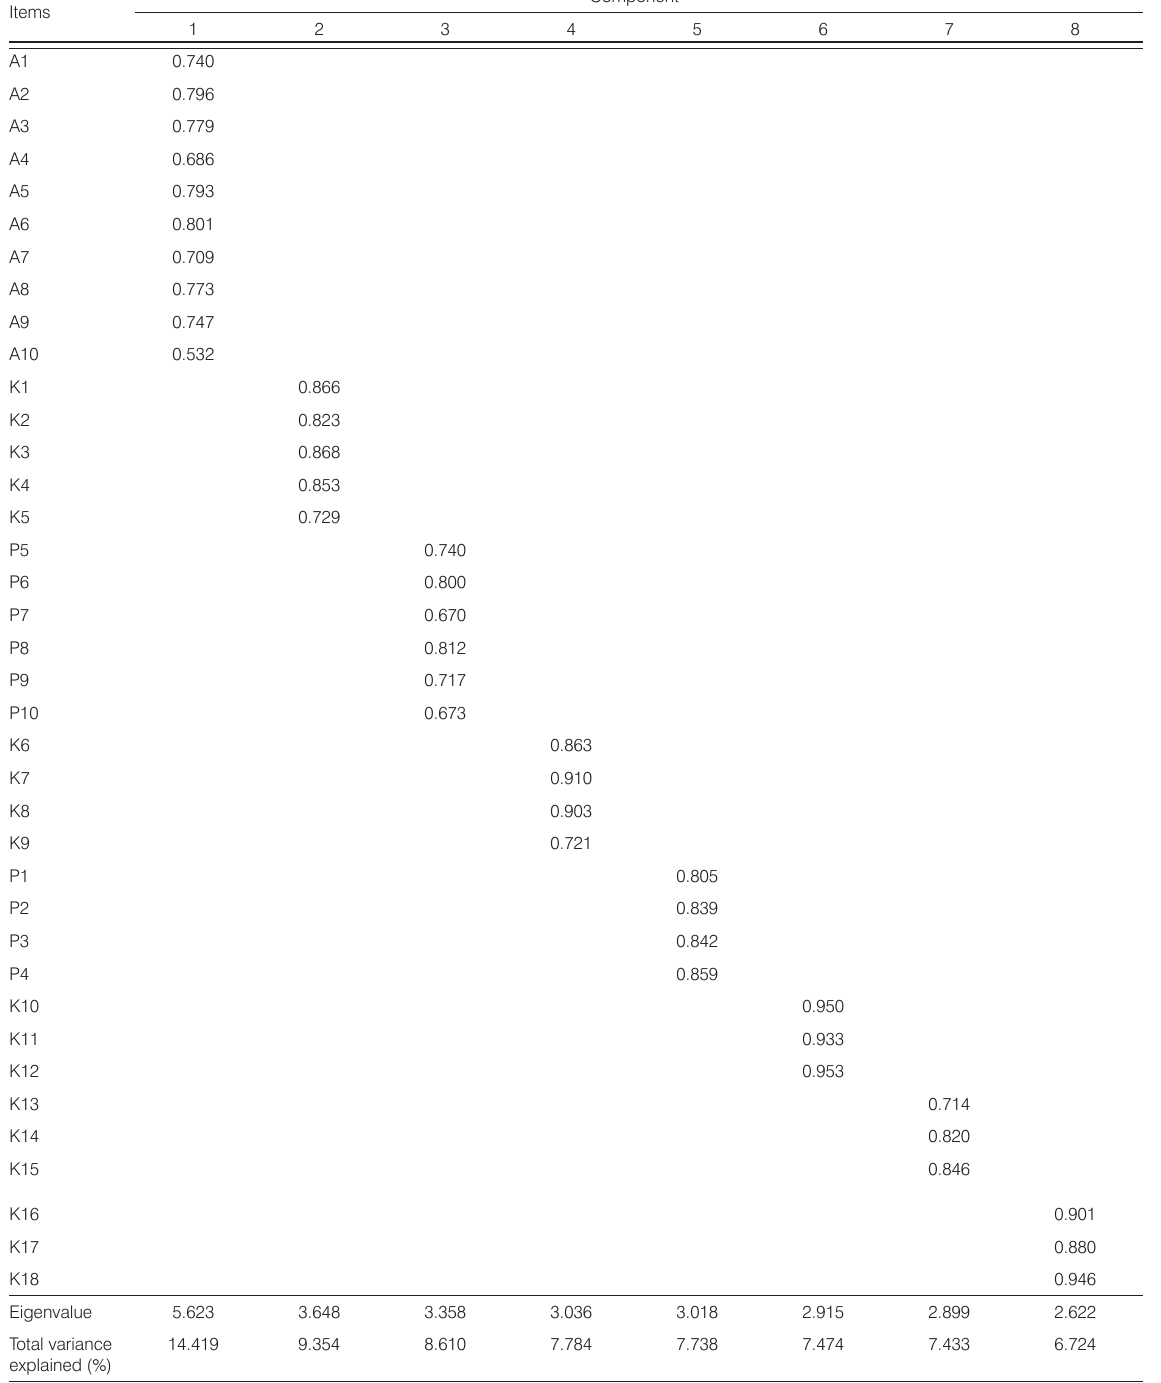
Table 7. Component matrix* of the